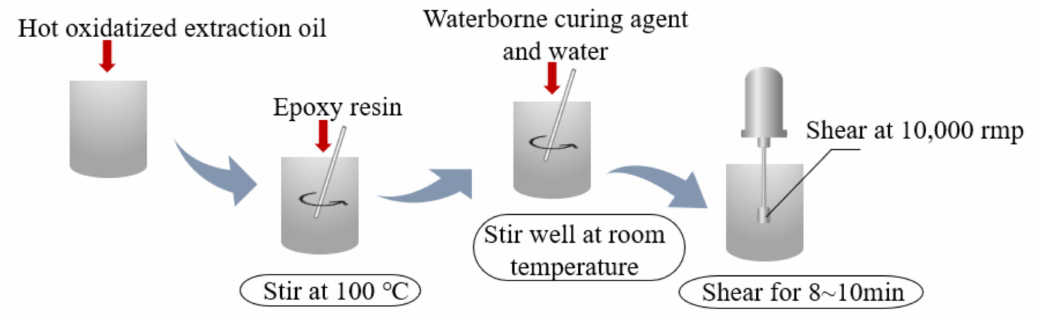
Figure 1. Preparation process of WER modified by oxidized extraction oil.